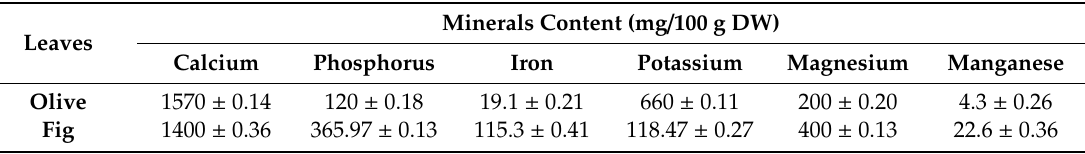
Table 2. Minerals composition of fig and olive leaves (mg / 100 g) on dry weight (DW)